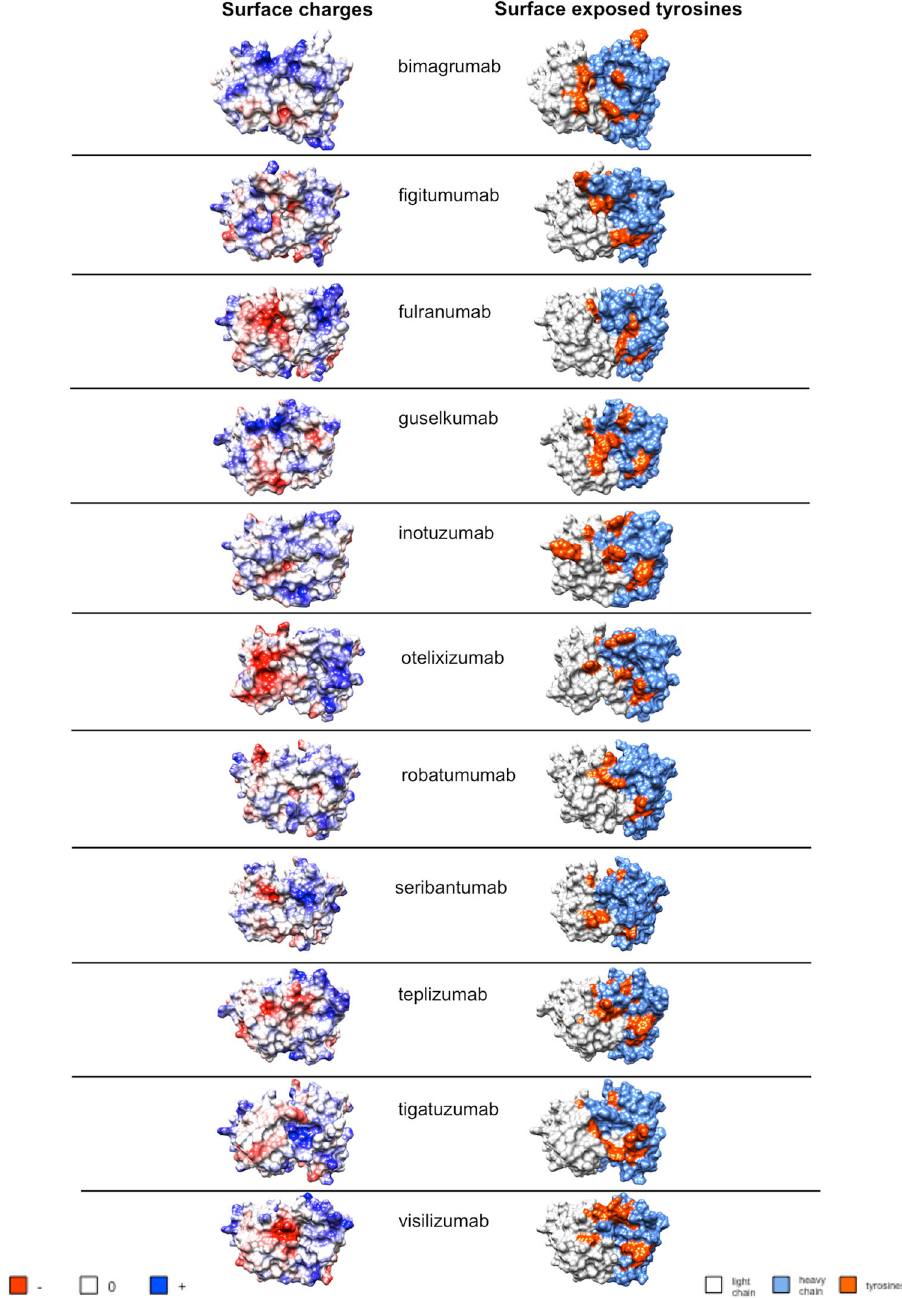
Fig. 6 Molecular features of antigen-binding sites of selected heme binding and heme sensitive Abs. (Left column) Coulomb ’ s electrostatic potential of antigen-binding sites of selected Abs. The distribution of the electrostatic charges (blue for positive charge and red for a negative charge) was colored using UCSF Chimera software. The selected polyreactive Abs demonstrated the most pronounced binding to immobilized heme and/or heme-induced polyreactivity. (Right column) Structural models of antigen-binding sites depicting the surface exposed Tyr residues. Gray: variable domain of light chain; blue: variable domain of heavy chain, orange: tyrosine residues. The structural models were visualized by using UCSF Chimera software. All structural models of the variable immunoglobulin regions were built by ROSSIE online